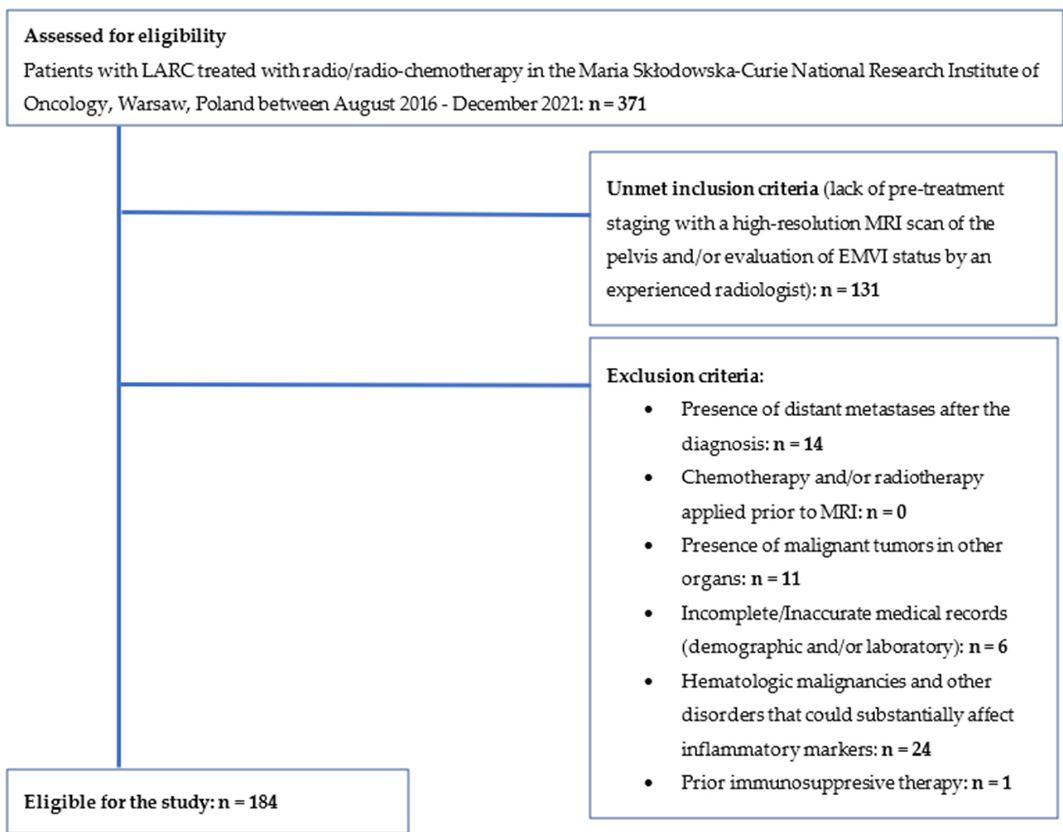
Figure 1. Eligibility for the study. LARC, locally advanced rectal cancer; MRI, magnetic resonance imaging; EMVI, extramural vascular invasion. Table 1. Calculation of LMR, NLR and PLR. Formulas: